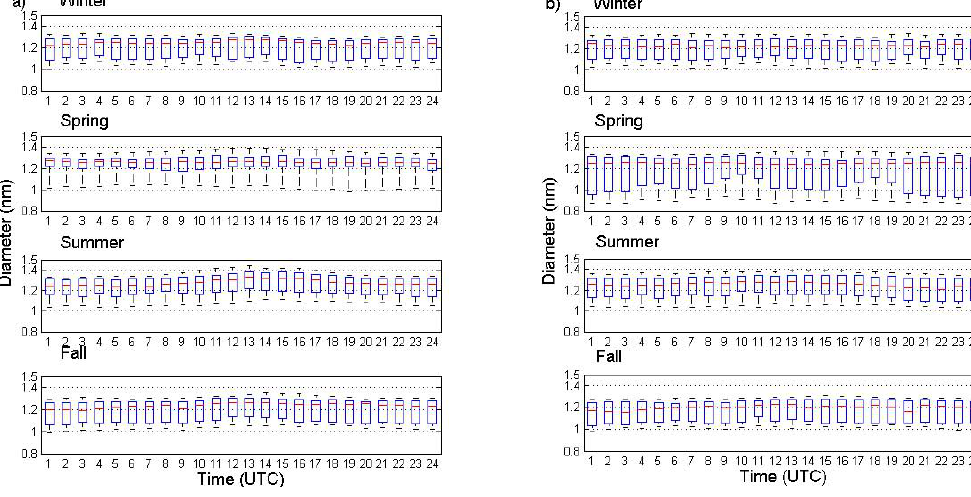
Fig. 6. Diurnal variation of the positive cluster ion mode (0.8–1.9nm) diameter on (a) event days and (b) non-event days. Red line represents the median value, bottom and top sides of the blue boxes symbolize the 25th and 75th percentile, respectively, and the extremities of the black lines stand for the 10th and 90th percentile. February 2007–February 2012, Puy de